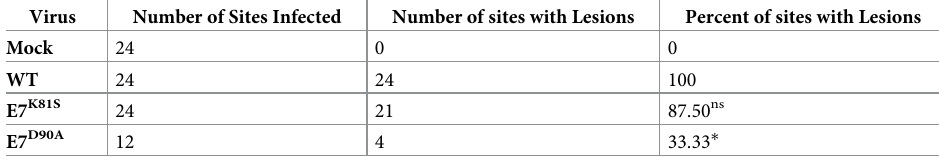
Table 1. Wart Incidence of infected Nude